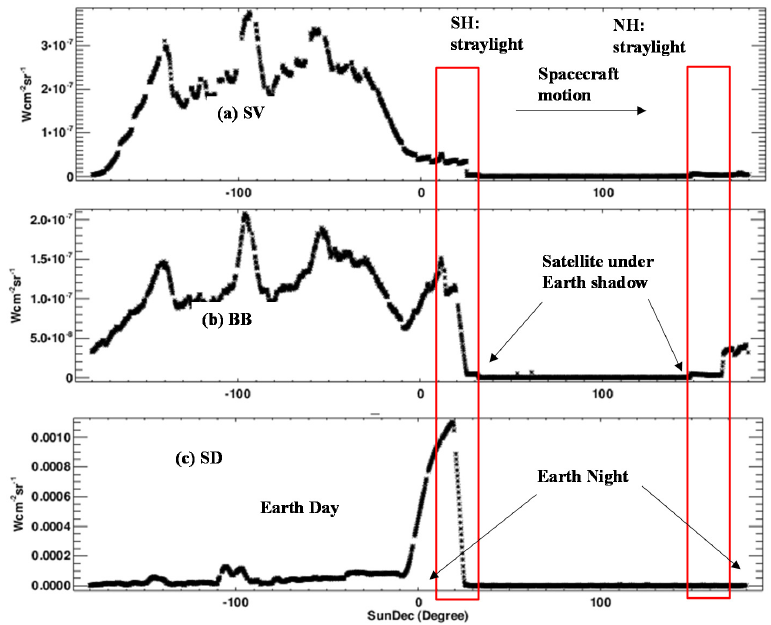
Figure 2. DNB calibration view signals for S-NPP orbit 15,758 on 12 November 2014. DNB detector 1 signals for SV, BB, and SD are shown in ( a – c ), respectively. The y-axis are DNB signals in W·cm − 2 ·sr − 1 . The x-axis is the VIIRS Sun declination angle, in degrees. NH: northern hemisphere, SH: southern hemisphere.